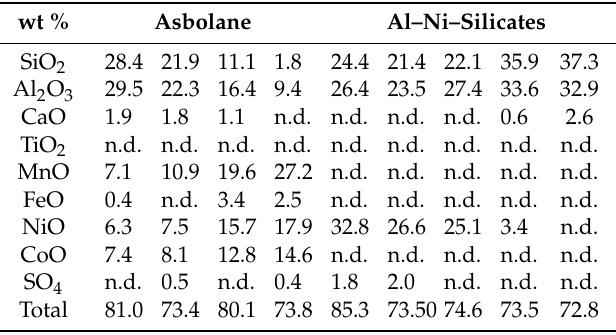
Table 7. Representative SEM-EDS analyses of fine-grained intergrowths of Al–Ni–silicates and asbolane (Profile II, Samples NB, Figures 3 and